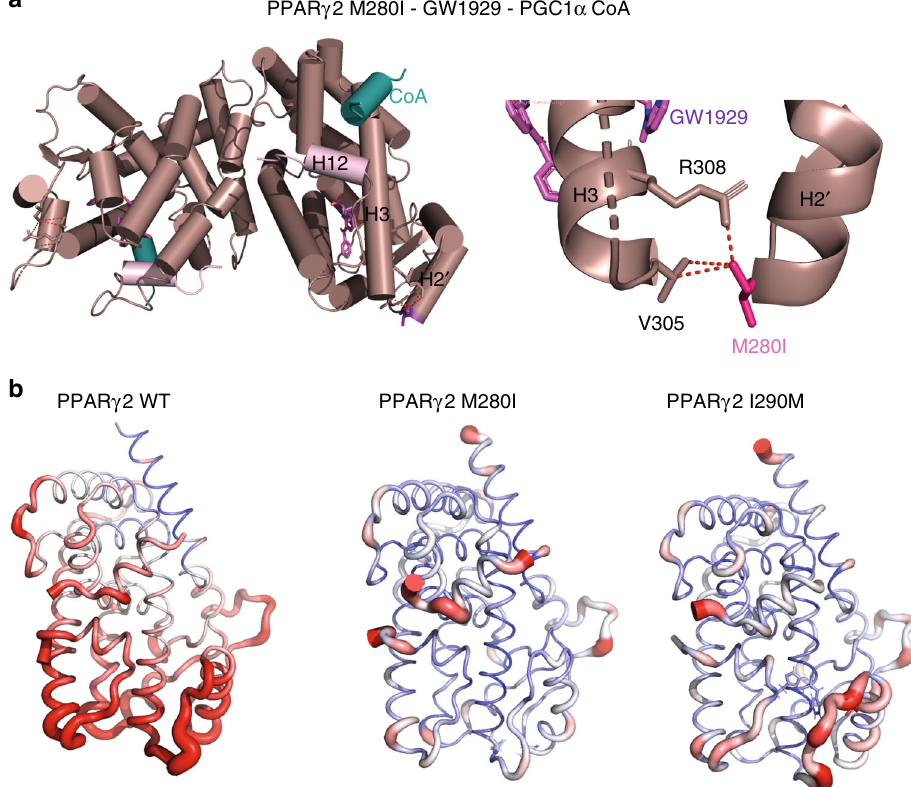
Fig. 5 Impact of PPAR γ M280I and I290M mutations on the structure and dynamics. a Crystal structure of the PPAR γ M280I LBD (plum) in complex with GW1929 (light red) and the PGC1 α coactivator peptide (blue). The C-terminal H12 are shown in light pink. Right: Close-up of the regions around the mutation, showing its interactions stabilizing helix 3. b The atomic fl uctuations calculated from the molecular dynamics simulation (last 10 ns) of the holo form of PPAR γ complexes with rosiglitazone and coactivator peptide. The fl uctuations are mapped onto the 3D surface of the proteins complexes. The color scale goes from blue (less fl exible) to red (most fl exible) between 0 and 2.5 Å. The thickness of the tube also re fl ects the fl exibility (thicker corresponds to more fl exible). Left: WT; middle: M280I; right: